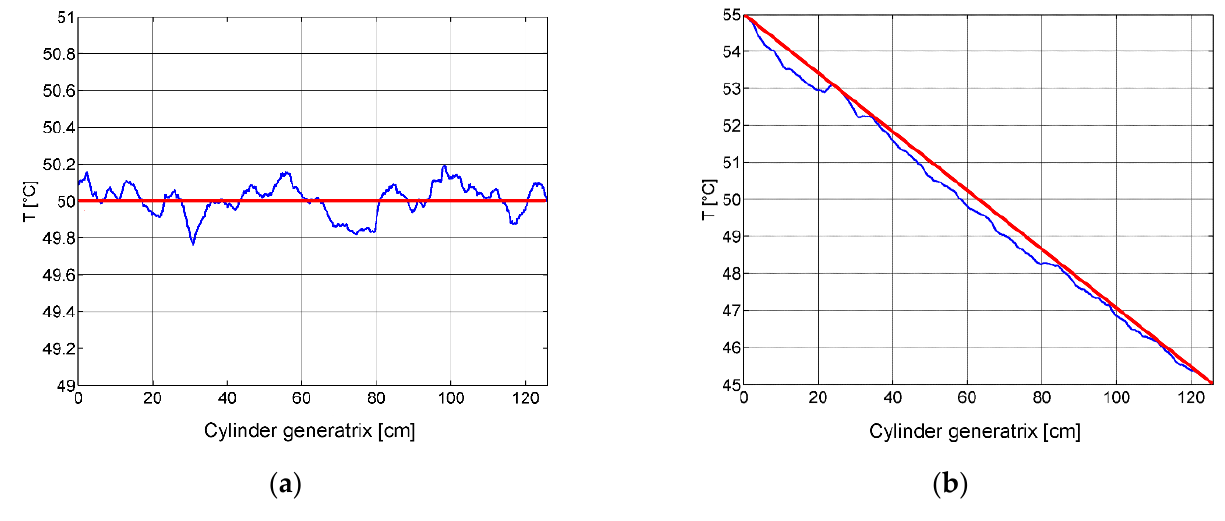
Figure 21. Transverse temperature profile of the surface of the cylinder after the first ( a ) and second ( b ) stages of the experiment (setpoint — red, measured value — blue).